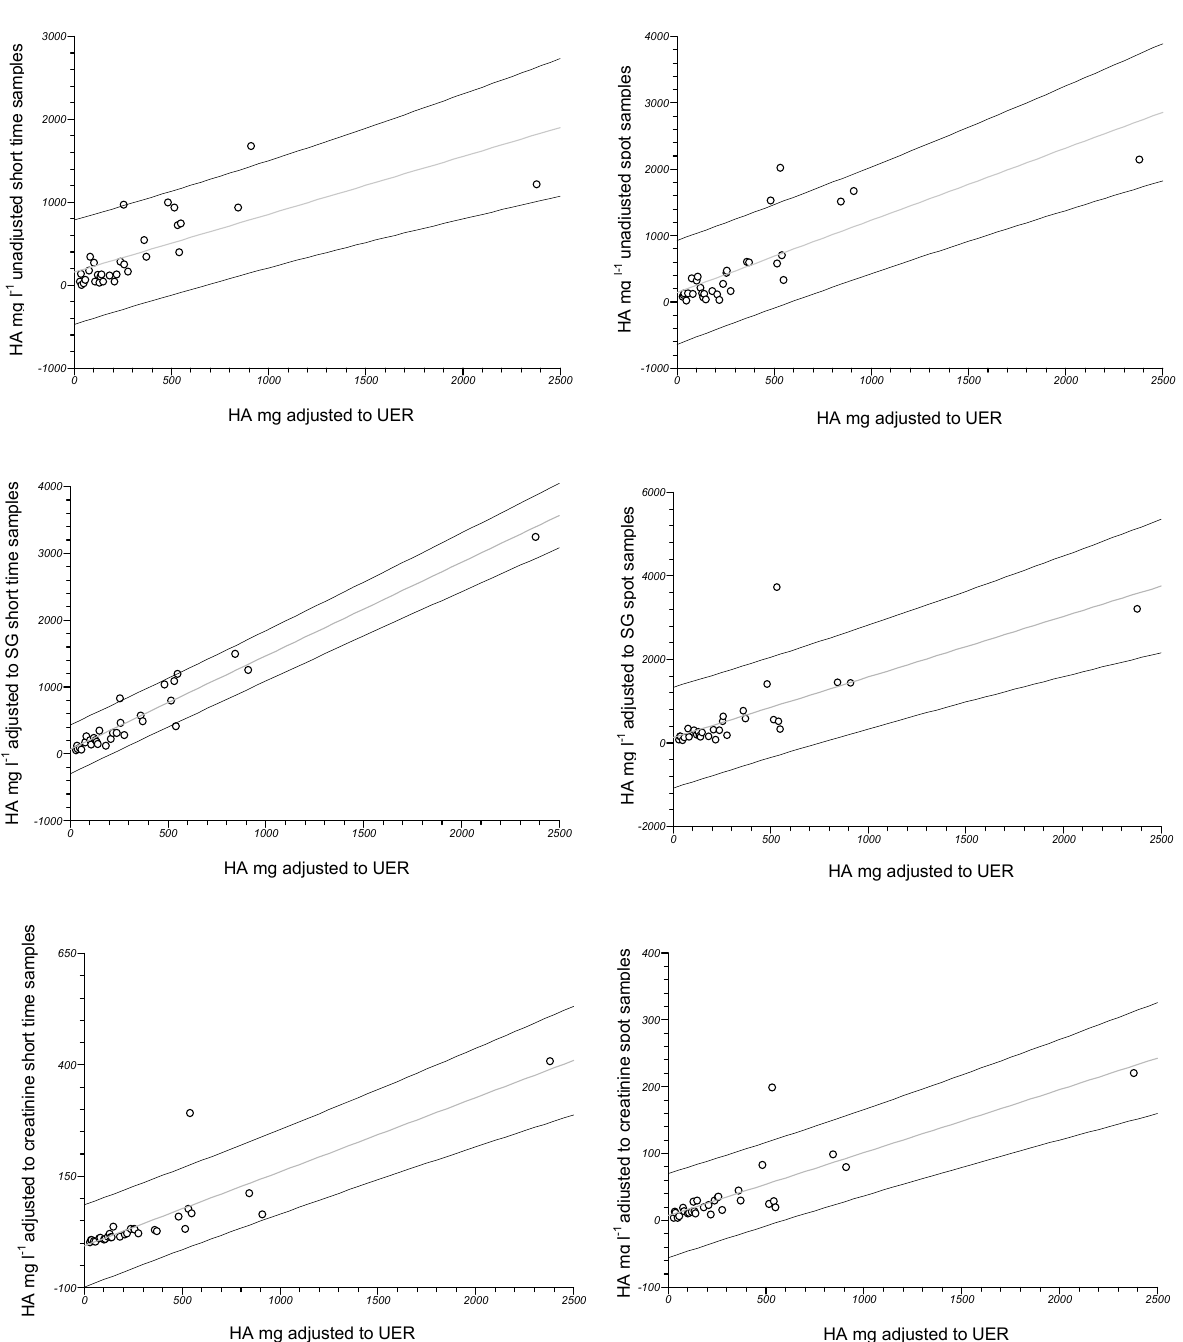
Figure 1. First line: correlation between HA y = 0.697 x + 158.937, r = 0.723, p < 0.0001) and spot samples (right: y = 1.086 x + 144.414, r = 0.795, p < 0.0001). Second line: correlation between HA (left: y = 1.399 x + 67.645, r = 0.964, p < 0.0001) and spot samples (right: y = 1.452 x + 128.947, r = 0.751, p < 0.0001). Third line: correlation between HA HA in short-term (left: y = 0.167 x − 6.306, r = 0.862, p < 0.0001) and spot samples (right: cn y = 0.094 x + 7.099, r = 0.817, p < 0.0001). The 95% C.I. was calculated (Fisher’s z transformation) and shown for each